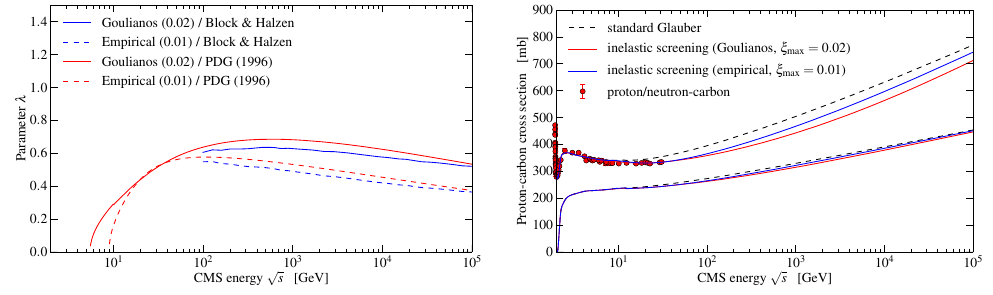
Figure 2. Left panel : energy dependence of the (cid:3) parameter for different choices of parameterizations and (cid:4) max (number in brackets). Right panel : comparison of model calculation with proton-nitrogen data ([31] and Refs. therein). The lower set of curves is the production cross-section.